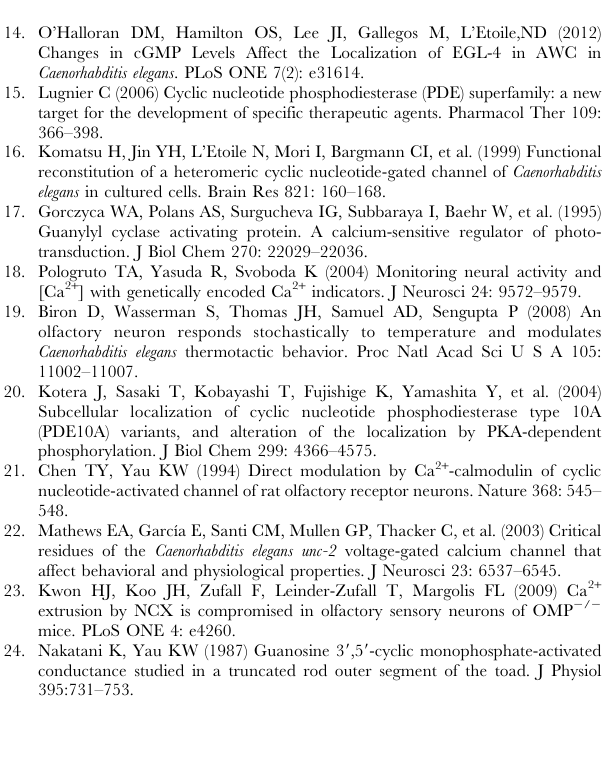
Figure S3 Changes in concentrations of intracellular pathway components. These were related to a combination of calcium buffer and calcium ions caused by addition or removal of odor stimulation. A. Free calmodulin (CaM)-like calcium buffer, B.